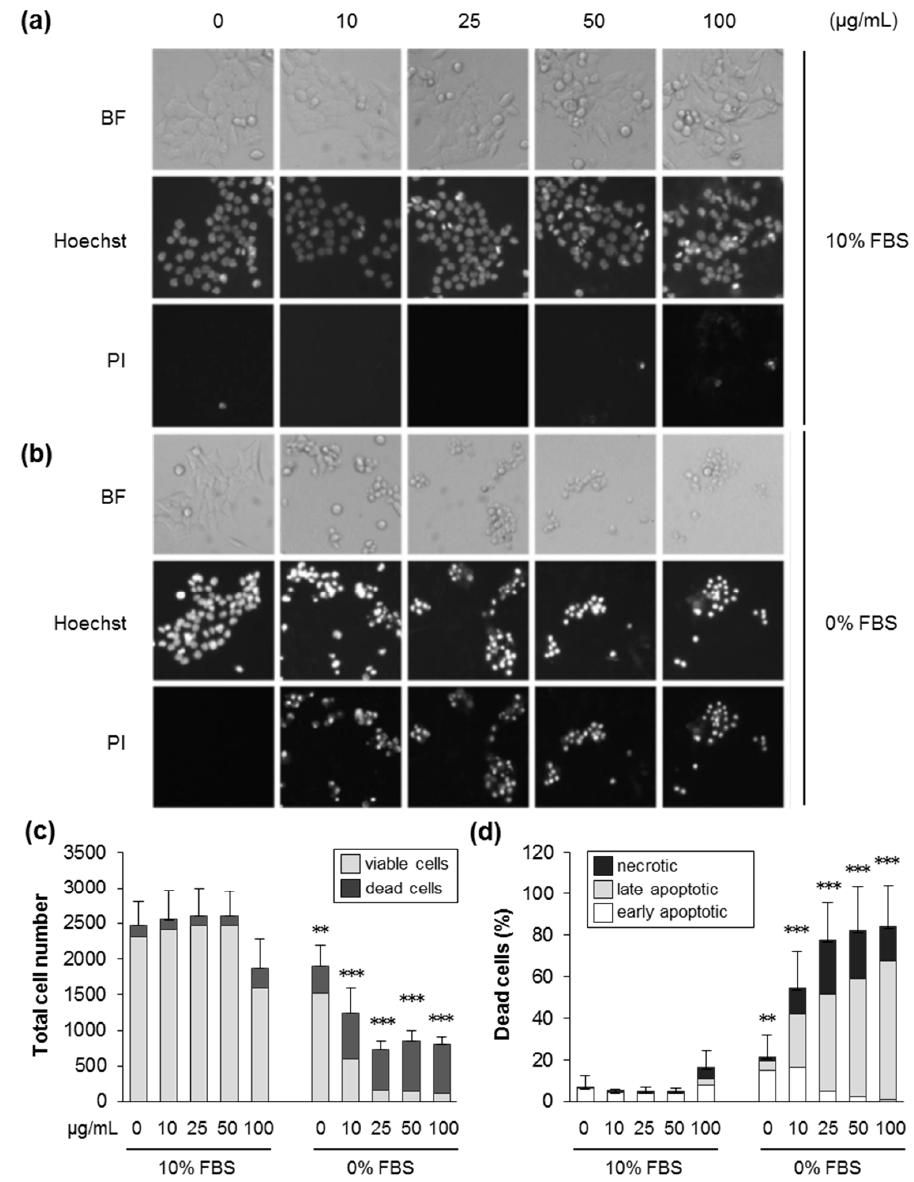
Figure 2. Silica NPs induce apoptotic and necrotic cell death in the absence of serum. HCT116 wt cells were incubated with SiO 2 —12 nm NPs at the indicated concentration in the presence (10% FBS) or absence (0% FBS) of serum. After 24 h, the cells were stained with Hoechst and propidium iodide (PI), and images were acquired by automated microscopy and analyzed by the scan^R software to deduce cell numbers and the different modes of cell death. ( a , b ) Representative images of cells treated as indicated in the brightfield, the Hoechst, and the PI channels. ( c ) The total cell number divided into living and dead cells after treatment, as indicated. ( d ) The percentage of dead cells relative to the total cell number divided into the different classes of cell death, as indicated. Data are represented as mean values of three independent experiments carried out with four replicates ( n = 12). The error bars are SD values related to the total cell number (c) or the percentage of dead cells (d). ** p < 0.01, *** p < 0.001 indicate significant differences in the response of cells treated with particles at corresponding concentrations in the absence (0% FBS) or the presence of serum (10% FBS).